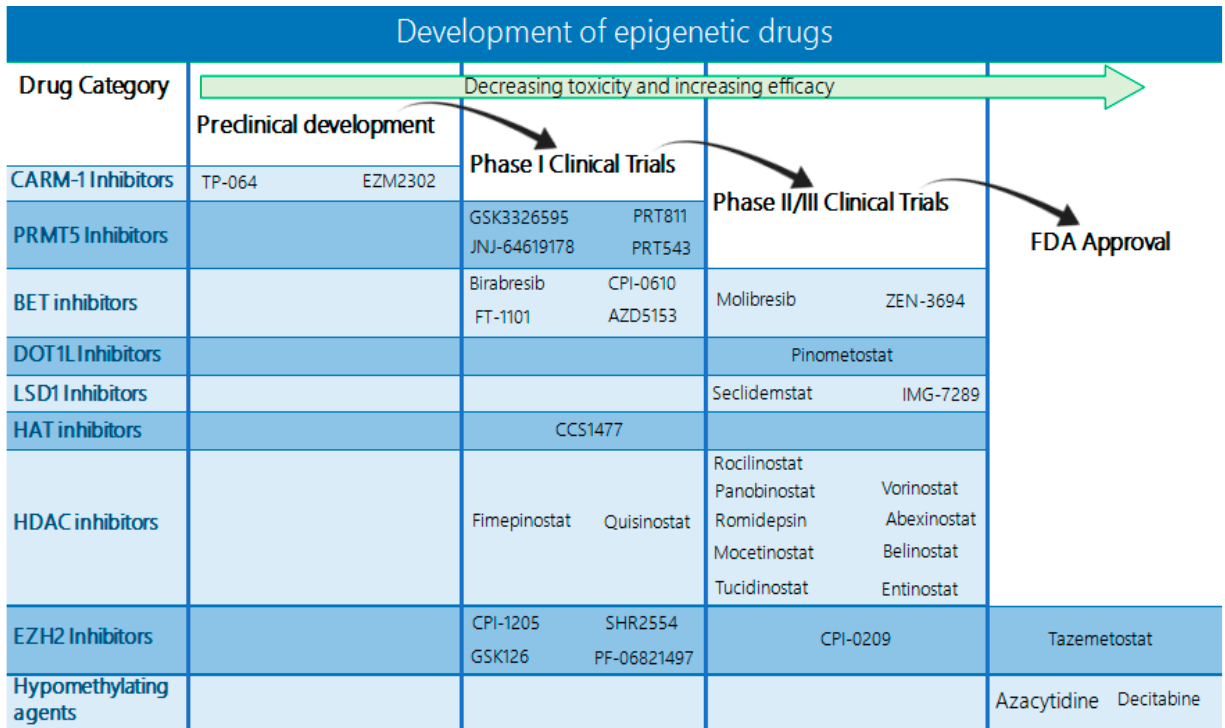
Figure 5. Diagram indicating the status of drugs targeting epigenetic alterations. Currently, only the EZH2 inhibitor tazemetostat and the DNMT inhibitors azacytidine and decitabine have received FDA approval. However, an increasing number of BET, DOT1L, LSD1, HAT, and HDAC inhibitors are already in phase II/III clinical trials with promising results, and several more are under evaluation in phase I trials.